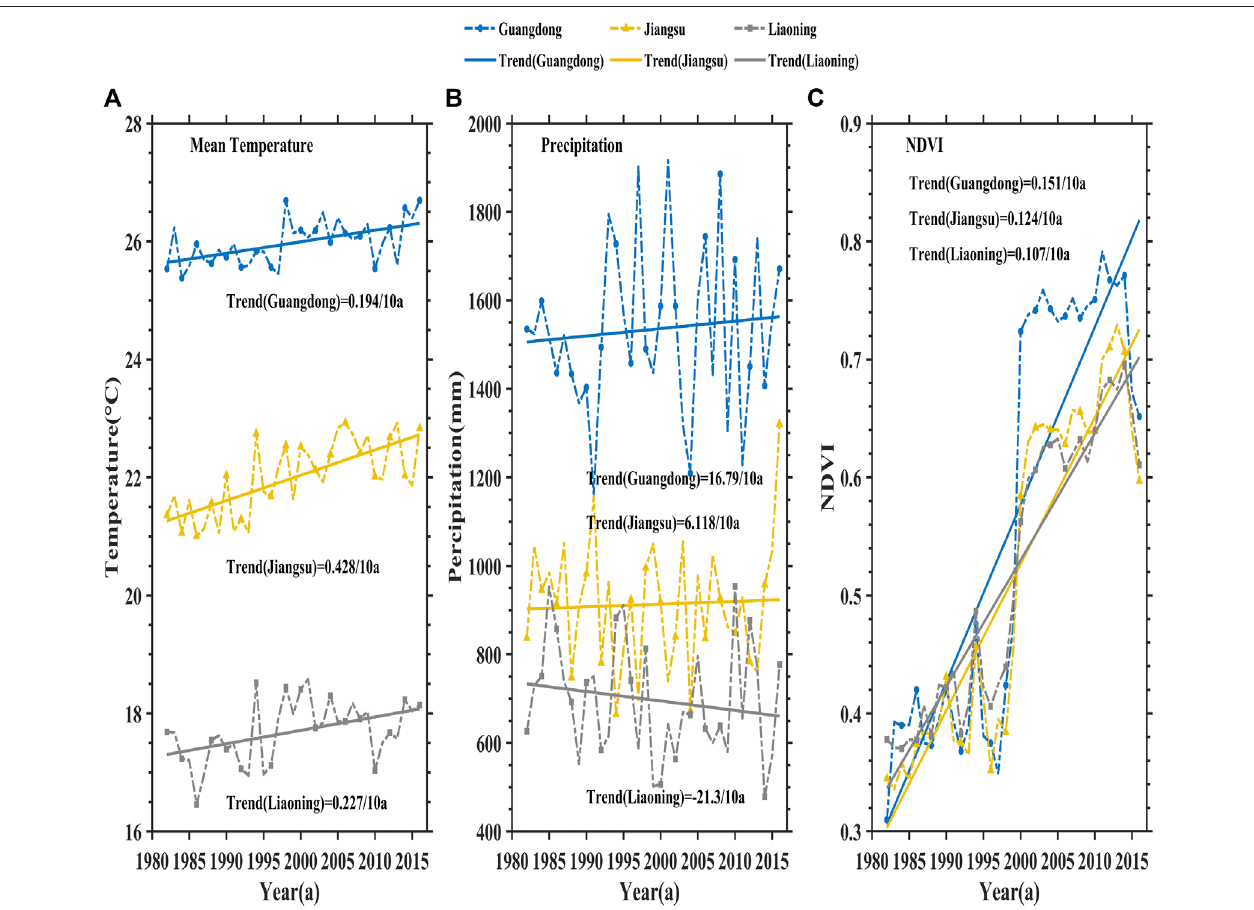
FIGURE2| Thehistoricaltrendvariationsofmeantemperature(Tavg),precipitation (Pre),andNDVIinGuangdong,Jiangsu,andLiaoningprovinces. (A) Themean temperature, (B) the precipitation, and (C) the normalized difference vegetation index (NDVI).